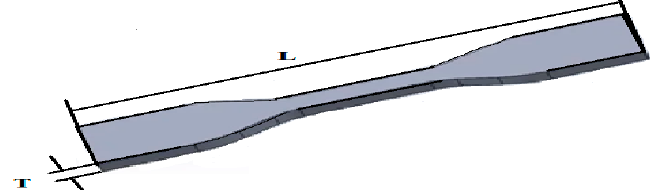
Figure A2. Locations to measure the dimensions of the sample.